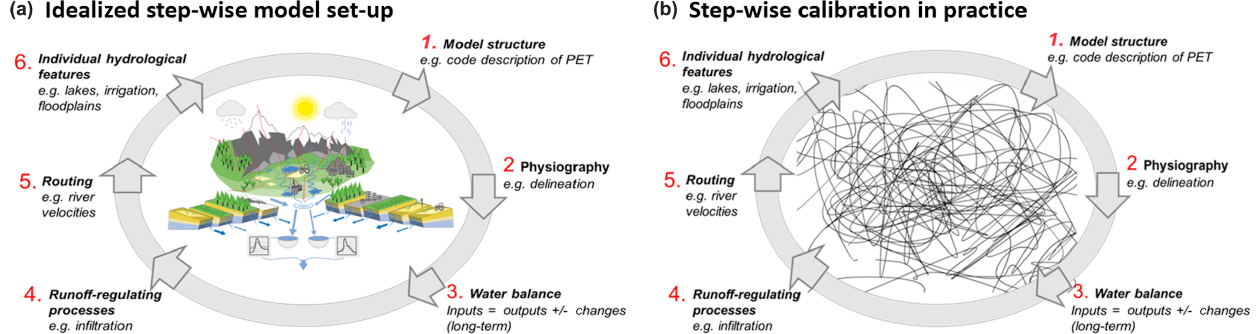
Figure 8. Discrepancy between the idealized procedure for stepwise calibration (a) and the numerous iterations between the steps that appear in reality (b) , leading to overall model